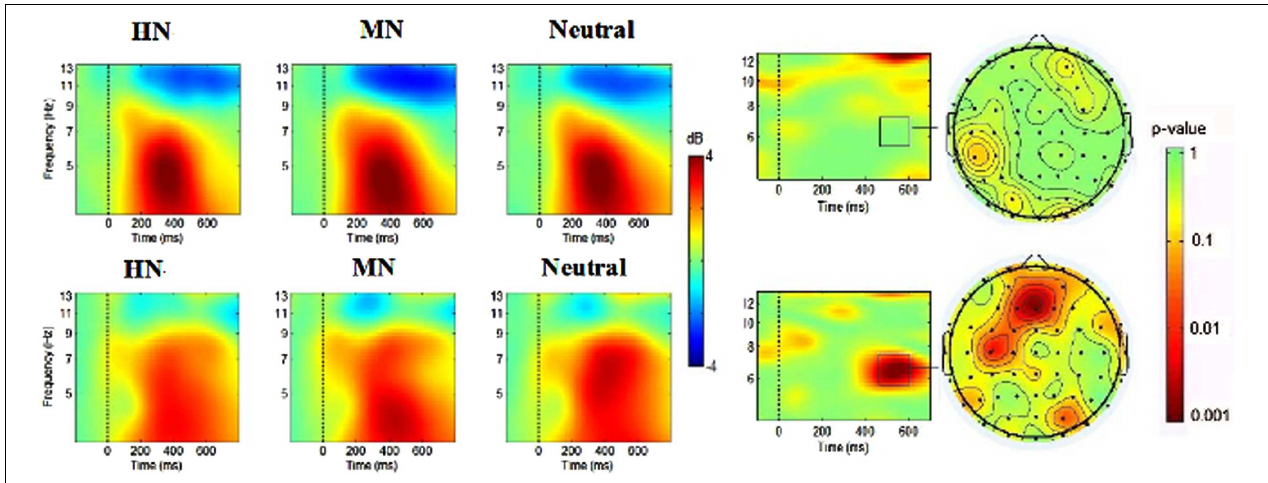
FIGURE 4 | (Left) The averaged EEG oscillatory activities during HN, MN, and Neutral conditions at Fz over time ( x -axis, 0 denotes picture onset) and frequency ( y -axis, 3–12 Hz). Blue color indicates power decrease relative to pre-stimulus baseline and red color indicates power increase relative to the baseline. (Right) The time-frequency map and the scalp distribution of the emotion effect across HN and MN stimuli in 500–600 ms ( Right , red color denotes smaller p values, and stronger significance level).